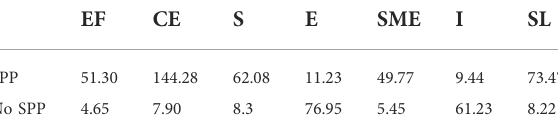
TABLE 9 SPP main category in % by type of contract ( n = 33,926).